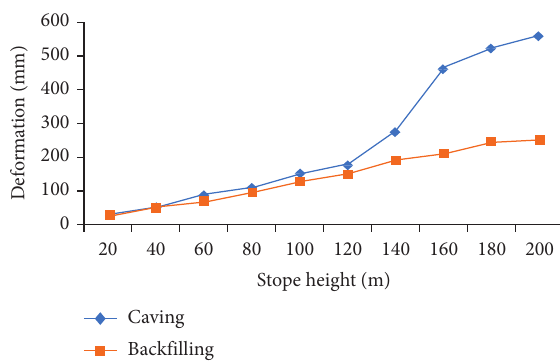
Figure 8: The maximum horizontal displacement comparison